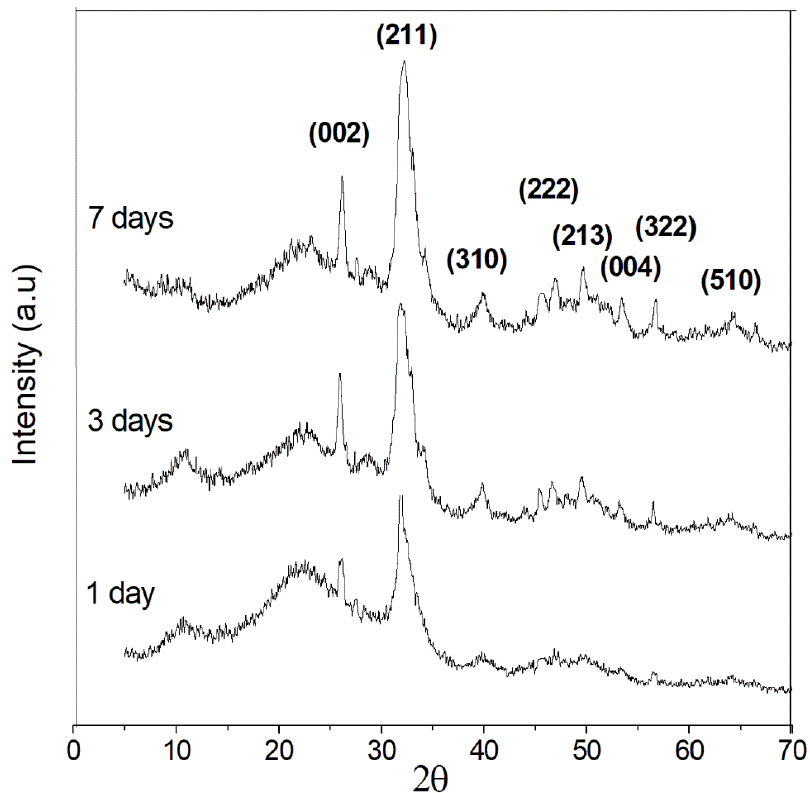
Figure 4. XRD patterns of bioactive glass after immersion in SBF for 1, 3 and 7 days.